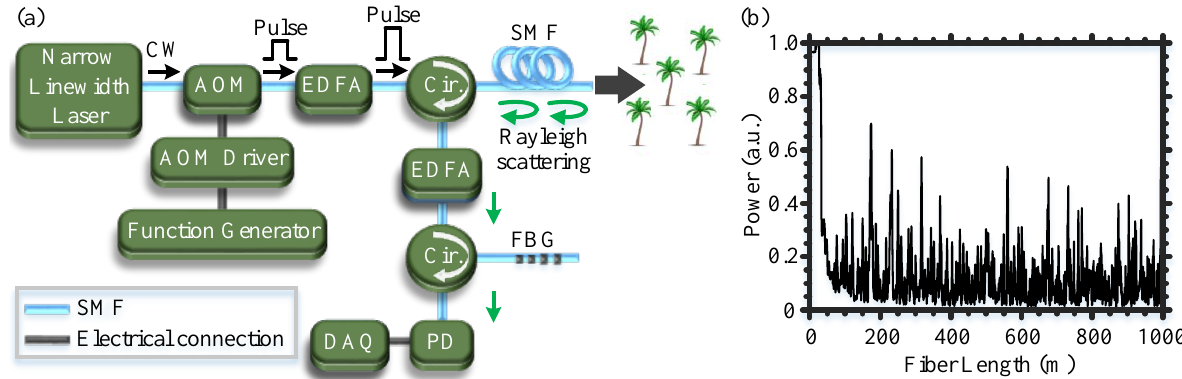
Figure 2. ( a ) Experimental setup of the Φ -OTDR-based optical fiber DAS used for the detection of RPW. Cir.: circulator. ( b ) A representative Rayleigh trace recorded by the optical fiber DAS along a 1-km